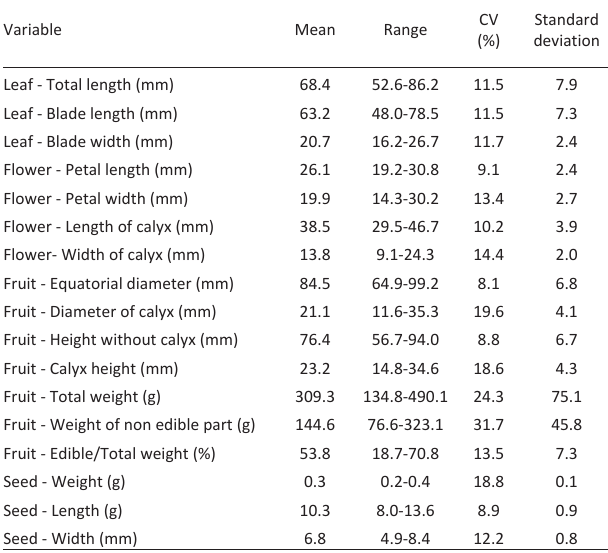
Table 1 - Mean values, ranges and coefficients of variation for 17 quantitative traits of pomegranate accessions of the National Fruit and Nuts Collection of